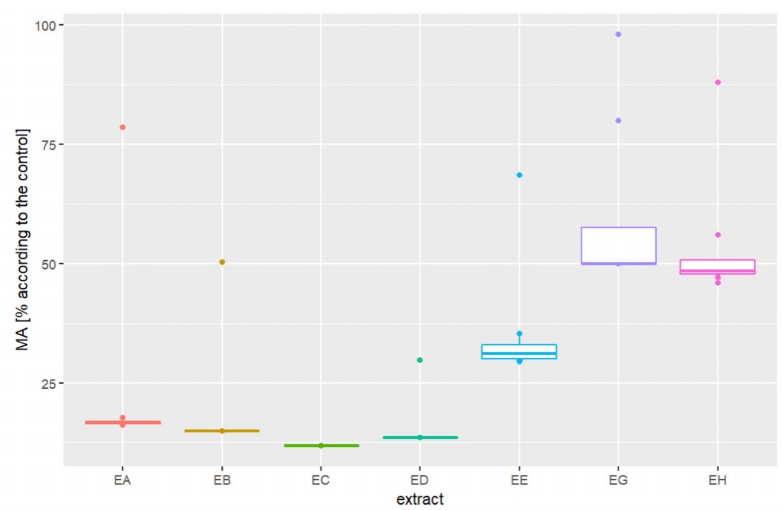
Figure A1. Comparison of cancer cell metabolic activity in % according to control between different hemp extracts.